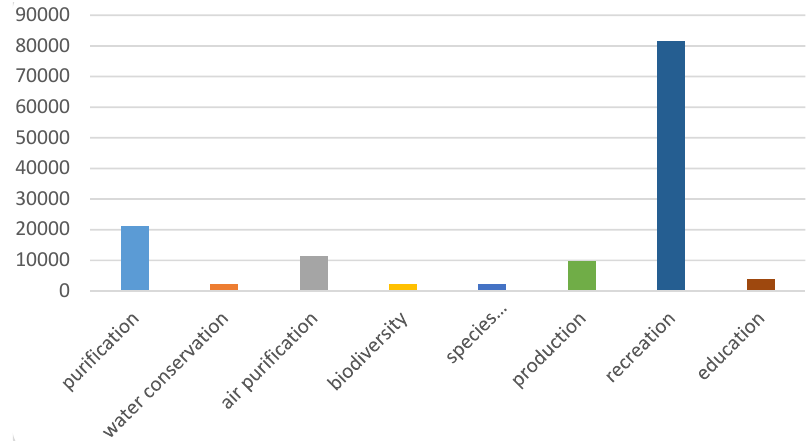
Figure 6. The composition of value in per unit in different service of Lakeside Wetland Park (unit: CNY).